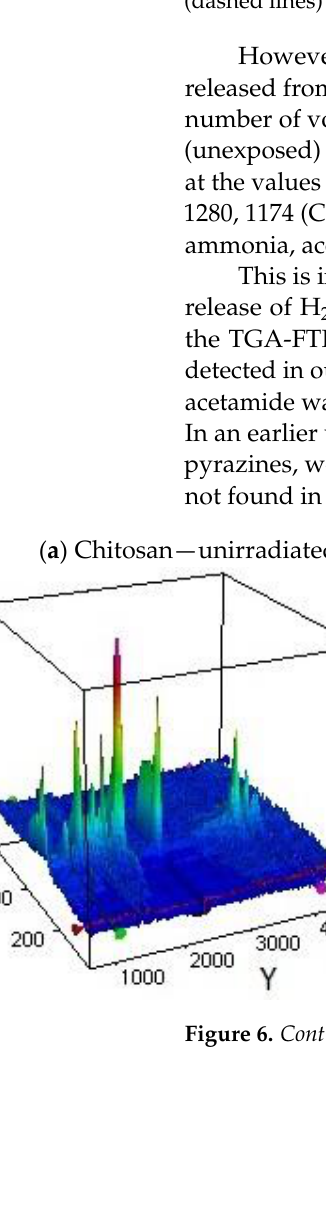
Figure 5. Comparison of TG, DTG, and DSC curves for unirradiated (solid lines) and 8 h UV-irradiated (dashed lines) samples: CS ( a ) CS-BIm ( b ), CS-BOx ( c ), and CS-BTh ( d ).